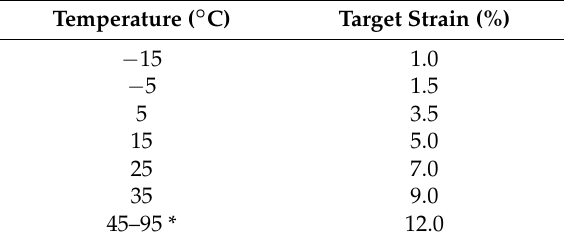
Table 6. Target strain values for linear viscoelastic